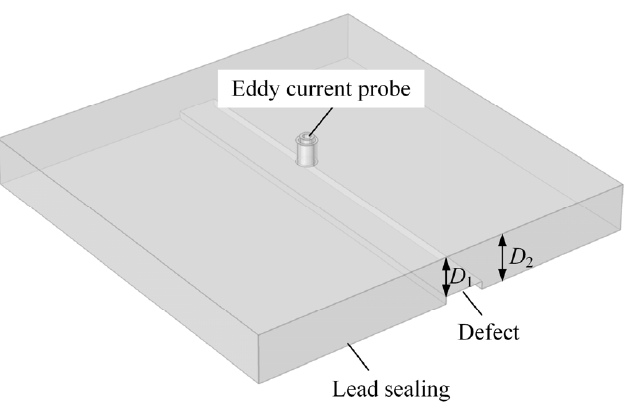
Figure 1. Schematic diagram of lead sealing samples with artificial defects.